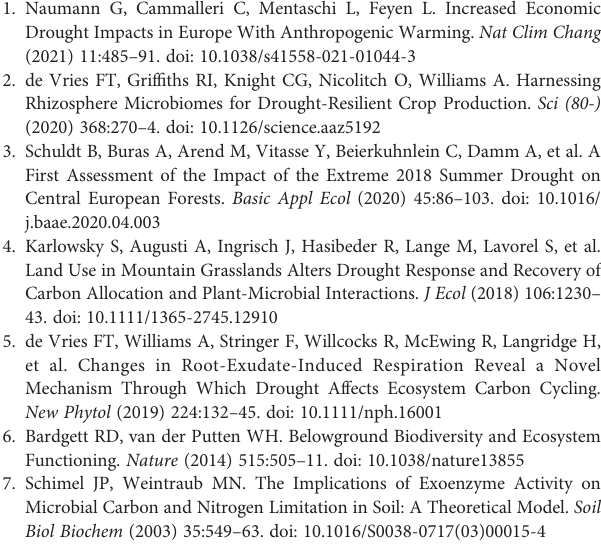
Supplementary Figure 2 | Map of the study site and sampling locations run by the Zwillingberg-Tietz Foundation (Map basis: © GeoBasis-DE/LGB [2020],